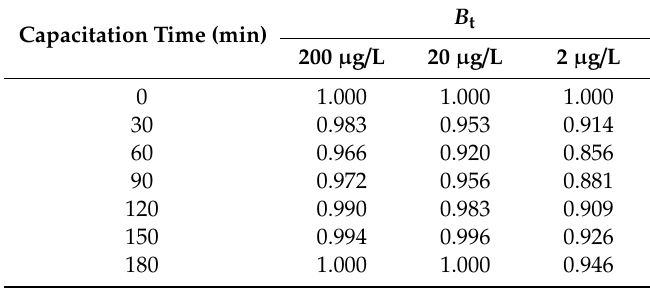
Table 1. Relative concentration B t calculated from the means of measured EE2 time-dependent concentrations C ( n ’ = 3) obtained during capacitation for three tested EE2 concentrations (see Figure